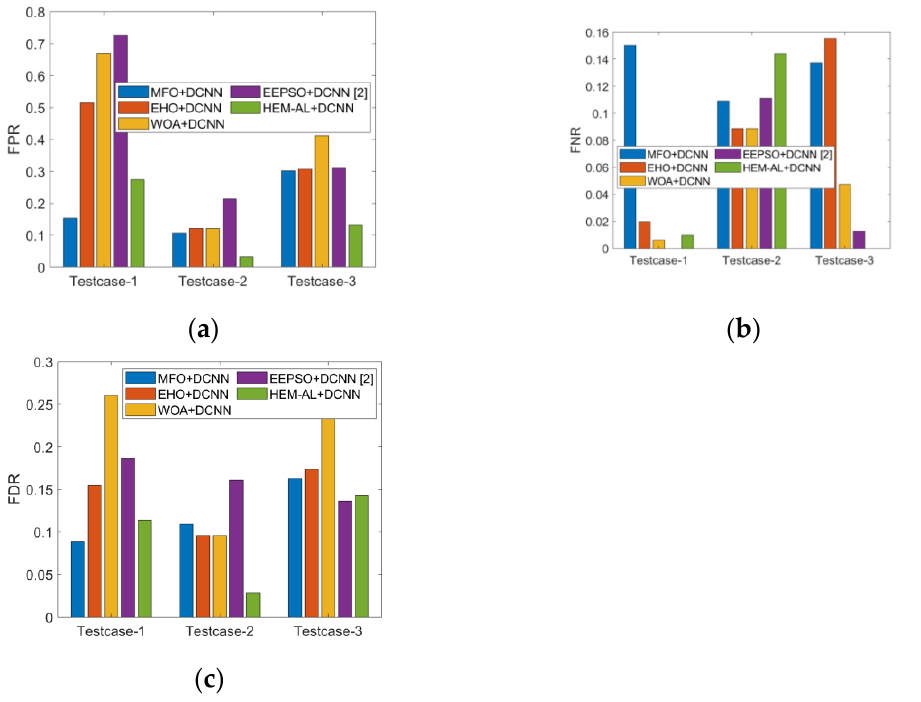
Figure 4. Performance of the developed scheme over extant schemes for “( a ) Accuracy ( b ) Sensitiv- ity ( c ) Specificity ( d ) Precision”.